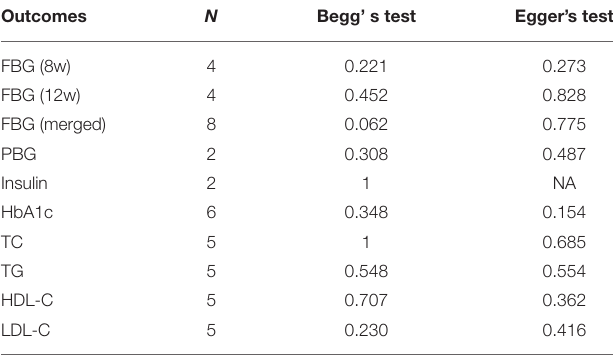
TABLE 3 | Assessment of publication